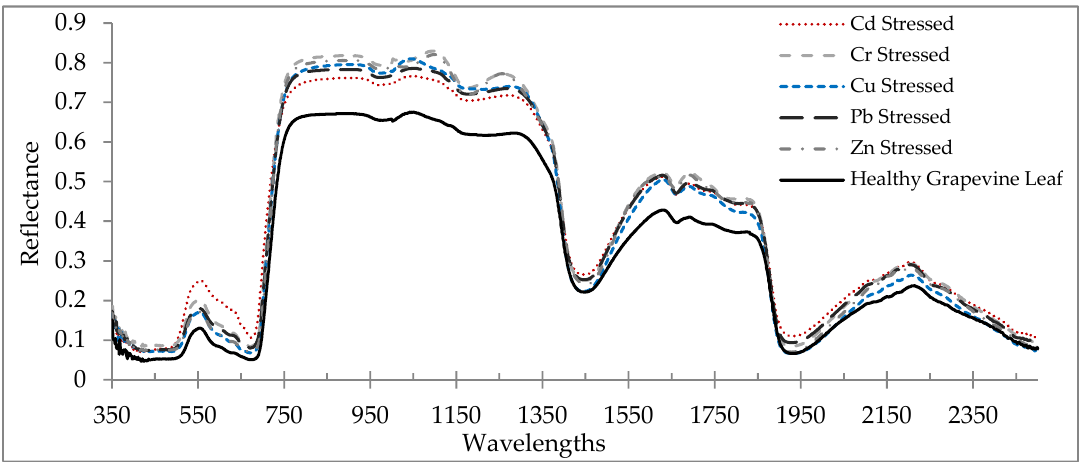
Figure 2. Average reflectance spectrum of healthy grapevine leaves vs. the heavy metal-stressed grapevine leaves (from 350 to 2500 nm).